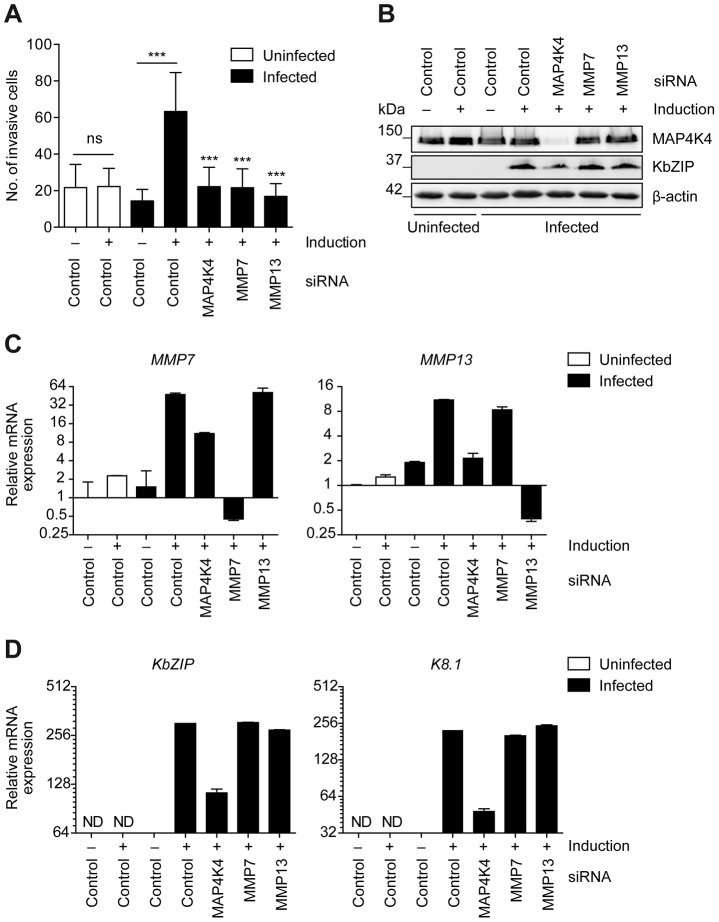
MMP7 and MMP13 are required for the invasiveness of KSHV-infected endothelial cells.HuAR2T or HuAR2T rKSHV.219 cells were transfected with control siRNA or siRNA pools targeting MAP4K4, MMP7 or MMP13 twenty-four hours before the induction of the lytic cycle. Thirty-six hours after lytic reactivation starved cells were analysed for invasiveness. (A) Invasion score determined by quantifying DAPI stained invasive cells during latency and in the course of lytic reactivation and presented as means ±SD of four independent experiments. The p values were determined using a One-way ANOVA with Tukey's multiple comparison post-test. p>0.05 (ns); p<0.05 (*); p<0.01 (**); p<0.001 (***); p<0.0001 (****). (B) Western blot analysis of MAP4K4 and KbZIP expression in HuAR2T and HuAR2T rKSHV.219 cells. The blot is one representative of four independent experiments with similar results. (C) qPCR analysis of MMP-7 and MMP-13 expression in HuAR2T and HuAR2T rKSHV.219 cells. The graph is one representative of four independent experiments with similar results. (D) qPCR analysis of KbZIP and K8.1 mRNA expression in HuAR2T and HuAR2T rKSHV.219 cells. The graph is one representative of four independent experiments with similar results.